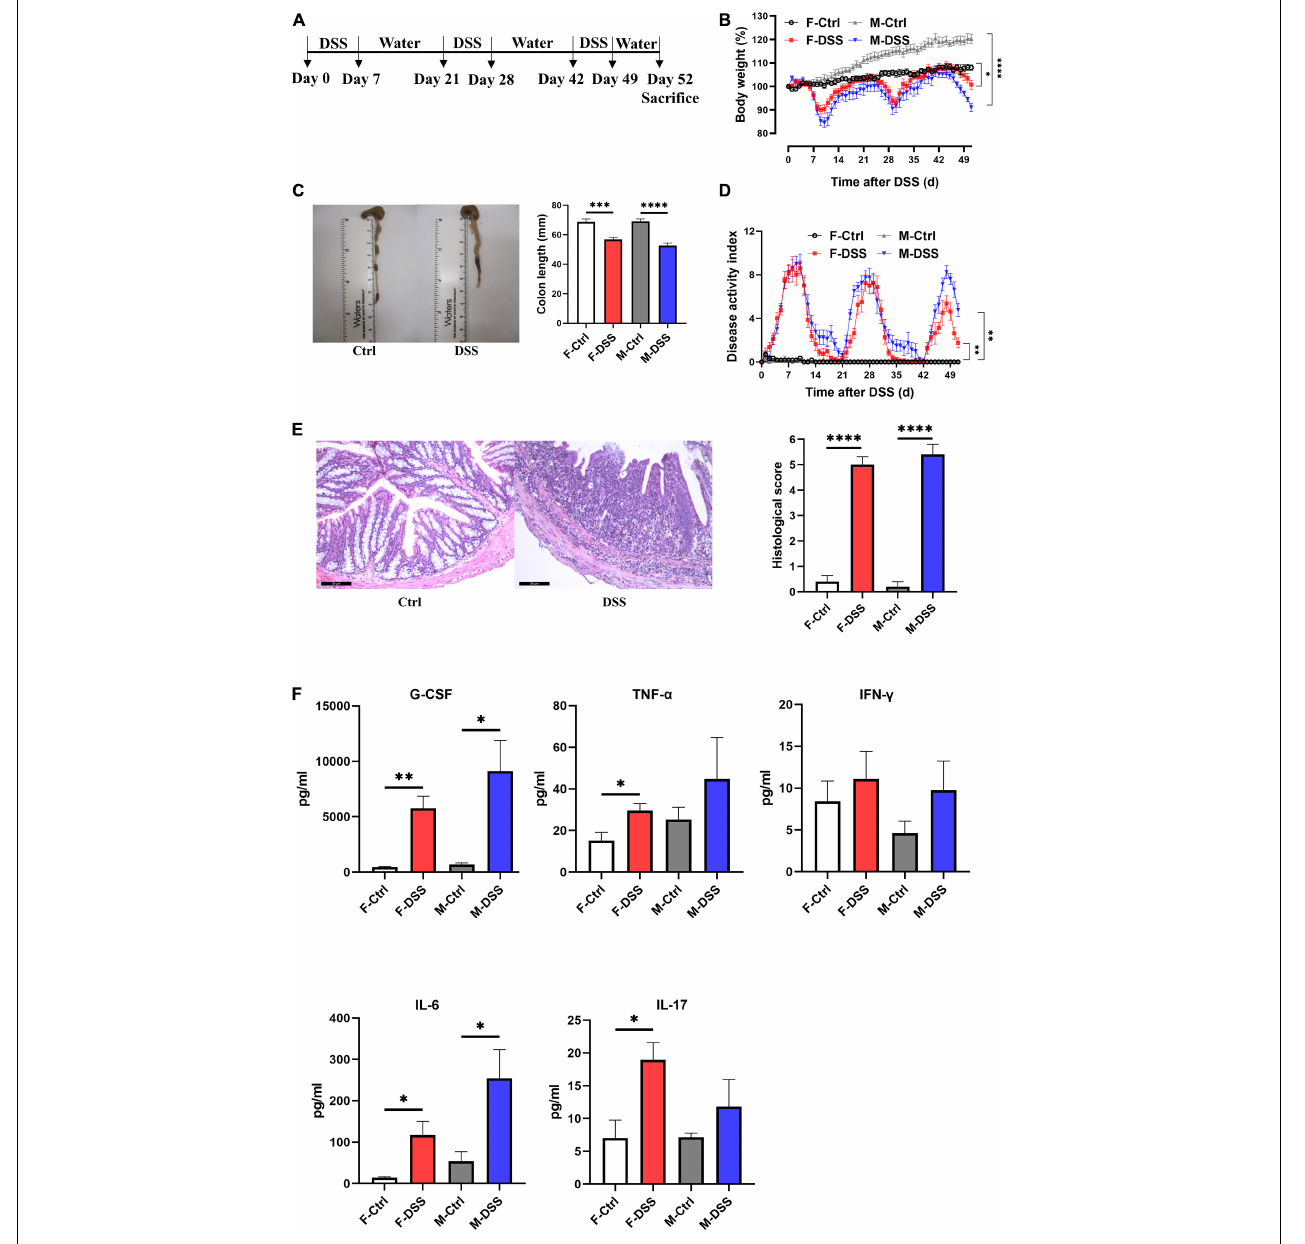
FIGURE 2 | Both female and male mice with chronic DSS-induced colitis displayed significant inflammation in the colon and systemic inflammation. (A) Experimental scheme illustrating the experimental protocol with treatment of DSS and water for chronic models. Changes in (B) body weight and (D) disease activity index (DAI) during DSS treatment. (C) Colon length and representative photographs for colon tissue in DSS-treated and control mice. (E) Representative images of H&E staining of colon tissue ( × 200; scale bar, 50 µ m), and summary of histological score. (F) Levels of plasma cytokines in male and female mice with chronic colitis model. Results are expressed as mean ± SEM. ∗ p < 0.05, ∗∗ p < 0.01, ∗∗∗ p < 0.001, ∗∗∗∗ p < 0.0001, in unpaired 2-tailed Student’s t -test (B–F) , n = 5–8 mice each group. F and M, female and male mice, respectively. G-CSF, granulocyte colony-stimulating factor; TNF- α , tumor necrosis factor alpha; IFN- γ , interferon gamma; IL,